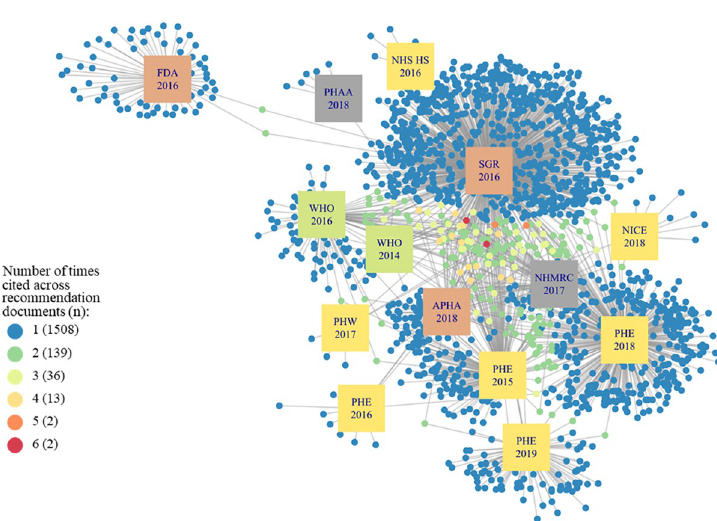
Fig 1. Citation network illustrating the 1700 evidence sources cited in 14 recommendation documents. APHA = American Public Health Association; FDA = U.S. Food and Drug Administration; NHMRC =